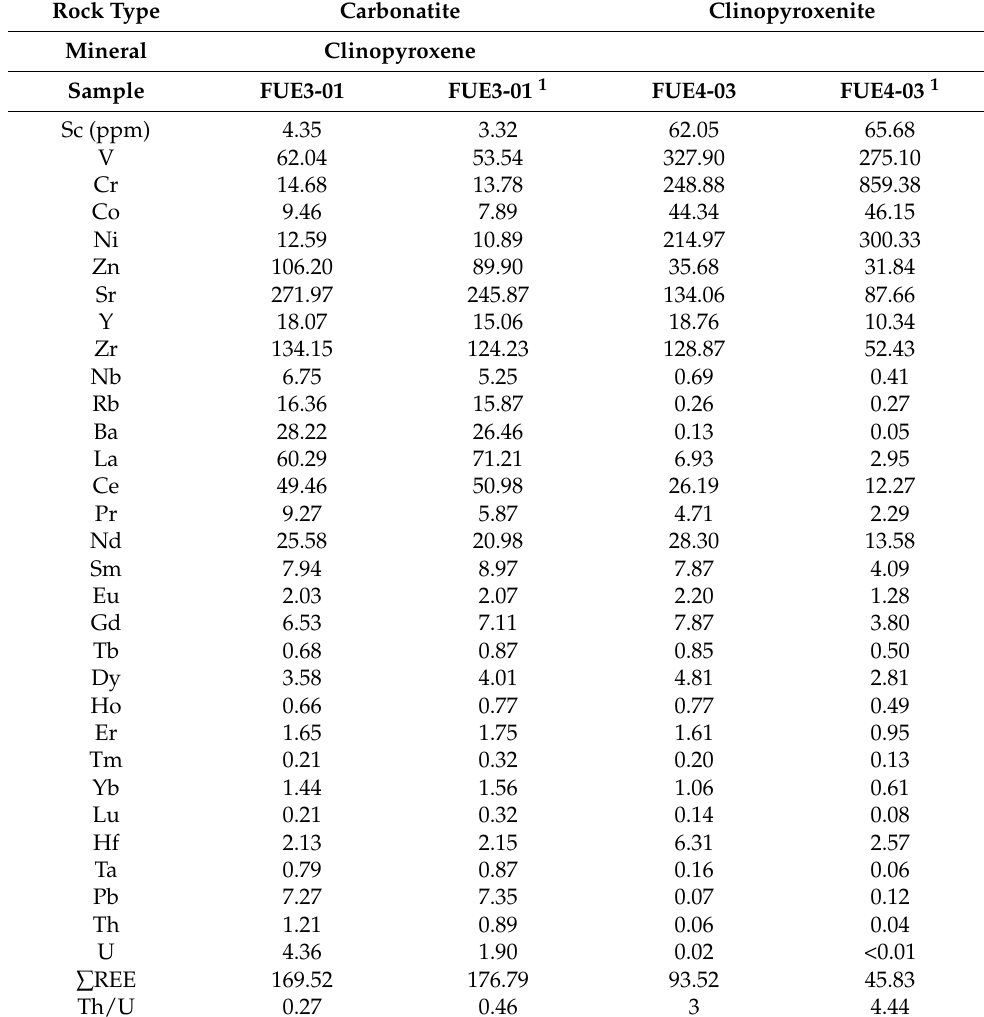
Table 3. Representative trace element compositions of clinopyroxene in Fuerteventura carbonatites and